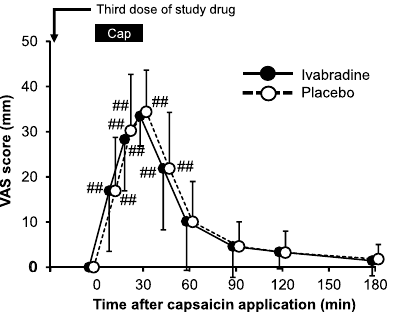
Figure 3. Effects of ivabradine and placebo on capsaicin-induced spontaneous pain assessed by visual analog scale (VAS) score. VAS scores in both groups gradually increased during the 30-min capsaicin application and gradually decreased after the end of capsaicin application. Data are expressed as means ± standard deviation, with n = 20 in each group. There were no significant differences in the VAS score between the groups throughout the study period. Statistical significance from baseline was indicated as # p < 0.05 and ## p < 0.01. Statistical analysis was performed using two-way ANOVA with Scheffe’s multiple comparisons post-hoc test. The bar labeled as “Cap” at the top of the panel depicts the onset and duration of capsaicin